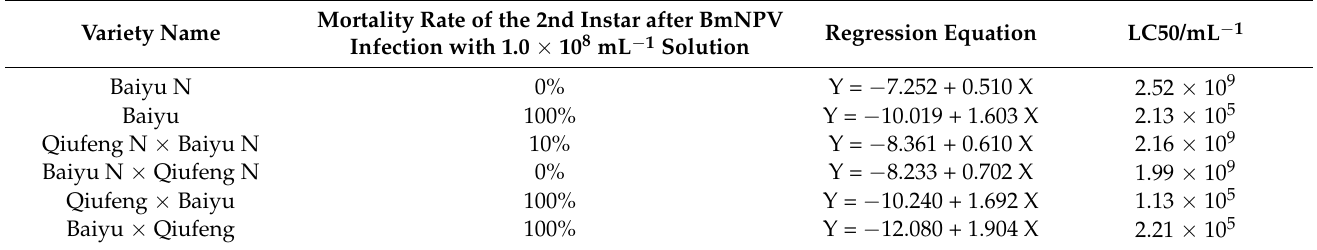
Table 1. Evaluation of resistance of the new bred silkworm varieties to BmNPV infection.